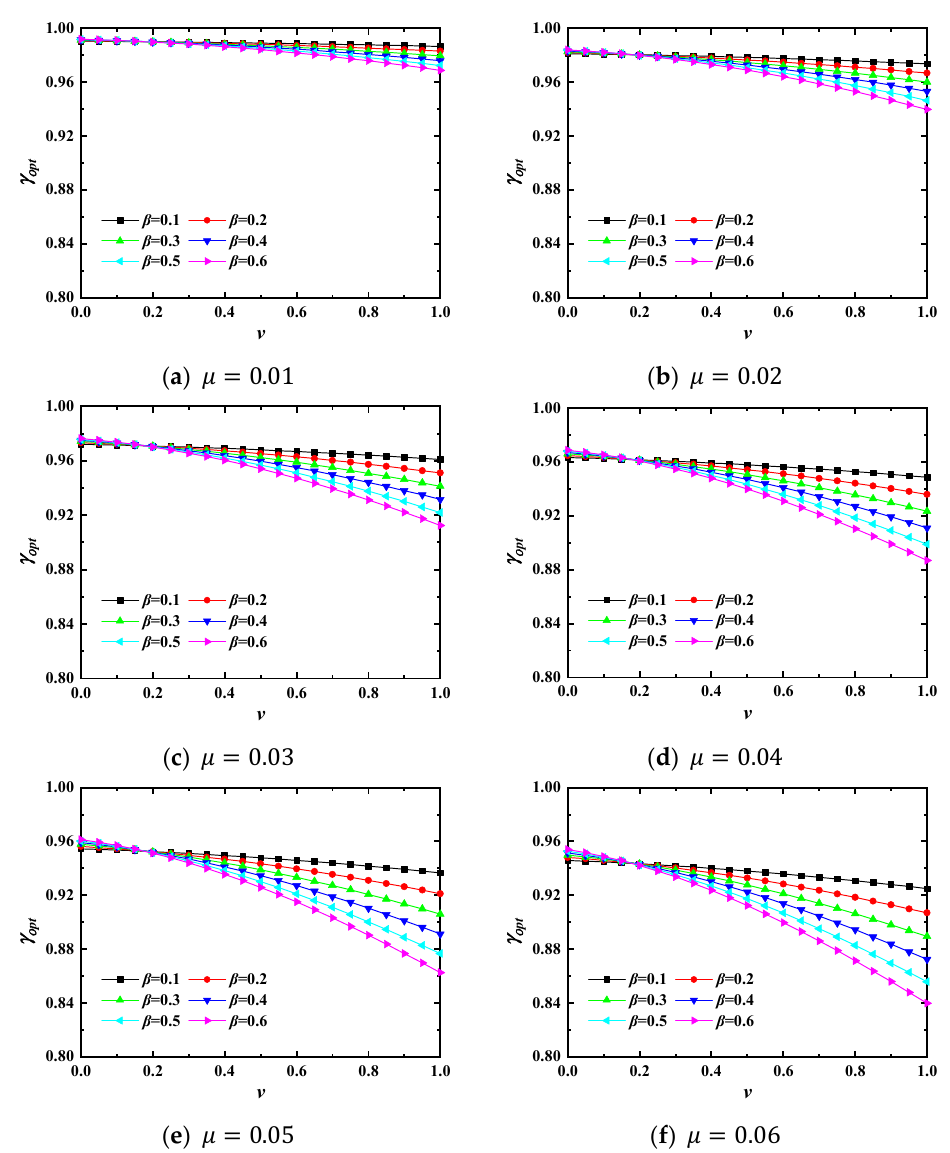
Figure 5. Optimal frequency ratio versus suspension location factor with different mass ratios and apparent mass ratios.